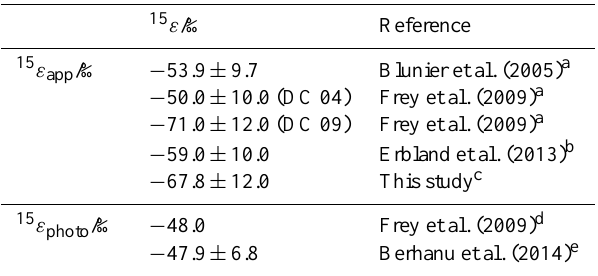
Table 4. Compiled 18 ε and 17 E values obtained from this study for the UV samples and previous